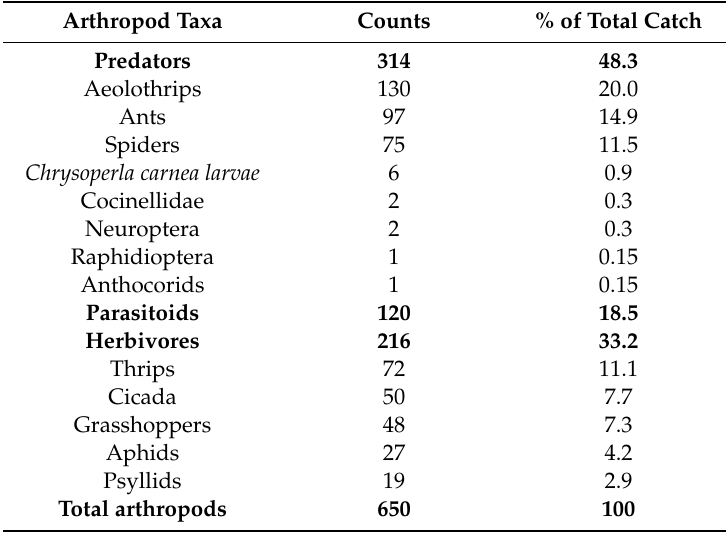
Table 2. Overview of main arthropod groups (predators, parasitoids, herbivores, in bold letters) and respective taxa trapped in vineyard plots on both sampling dates.